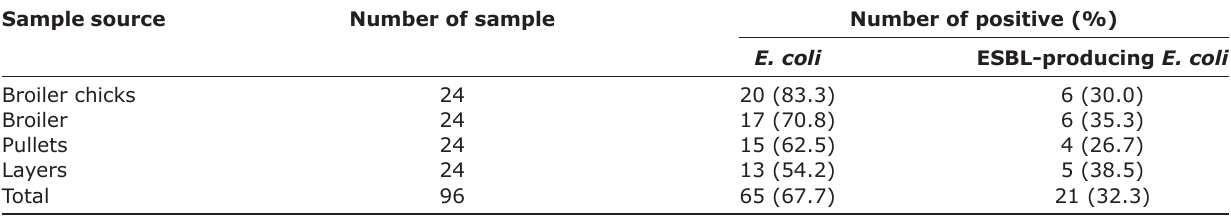
Table-1: Occurrence of E. coli and ESBL-producing E. coli in chickens from small-scale poultry farms in Maiduguri.